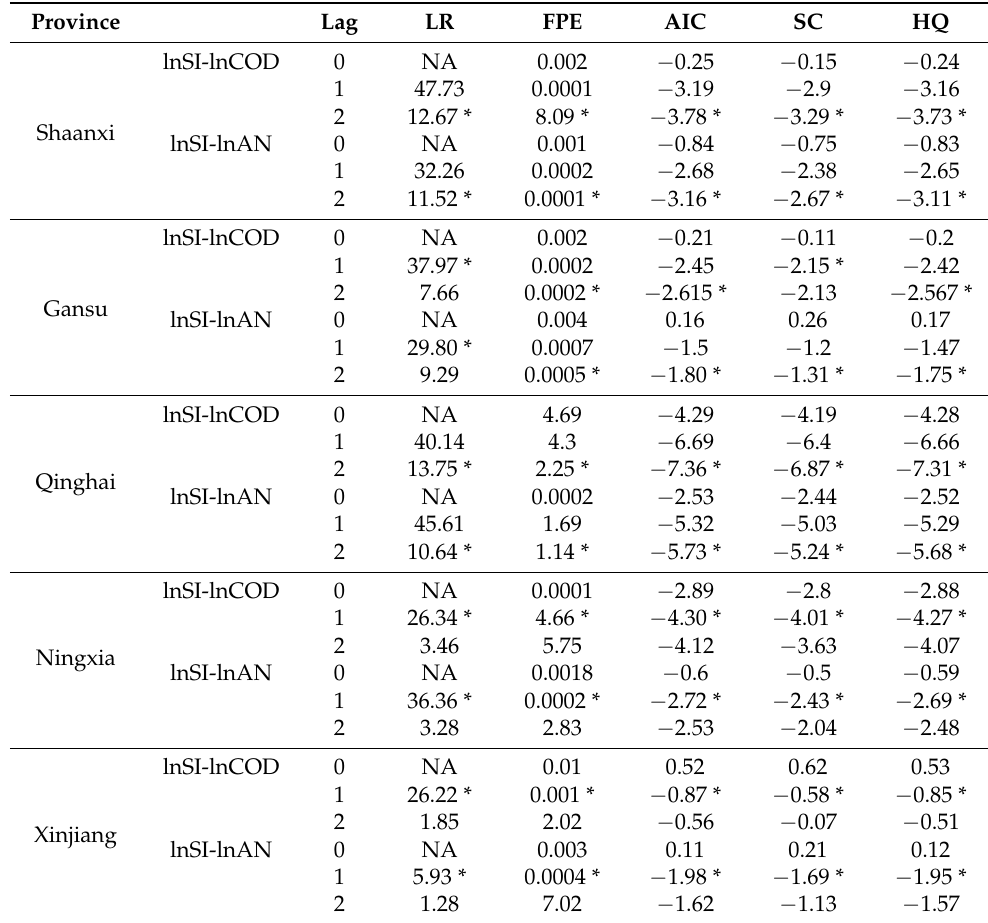
Table 3. The optimal lag period of the VAR